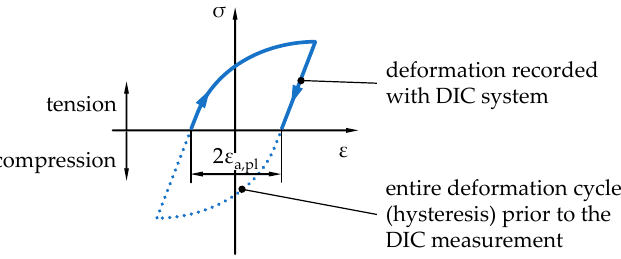
Figure 4. Locally forming hysteresis loops under cyclic deformation and measured strain in tension by digital image correlation (DIC; schematic).